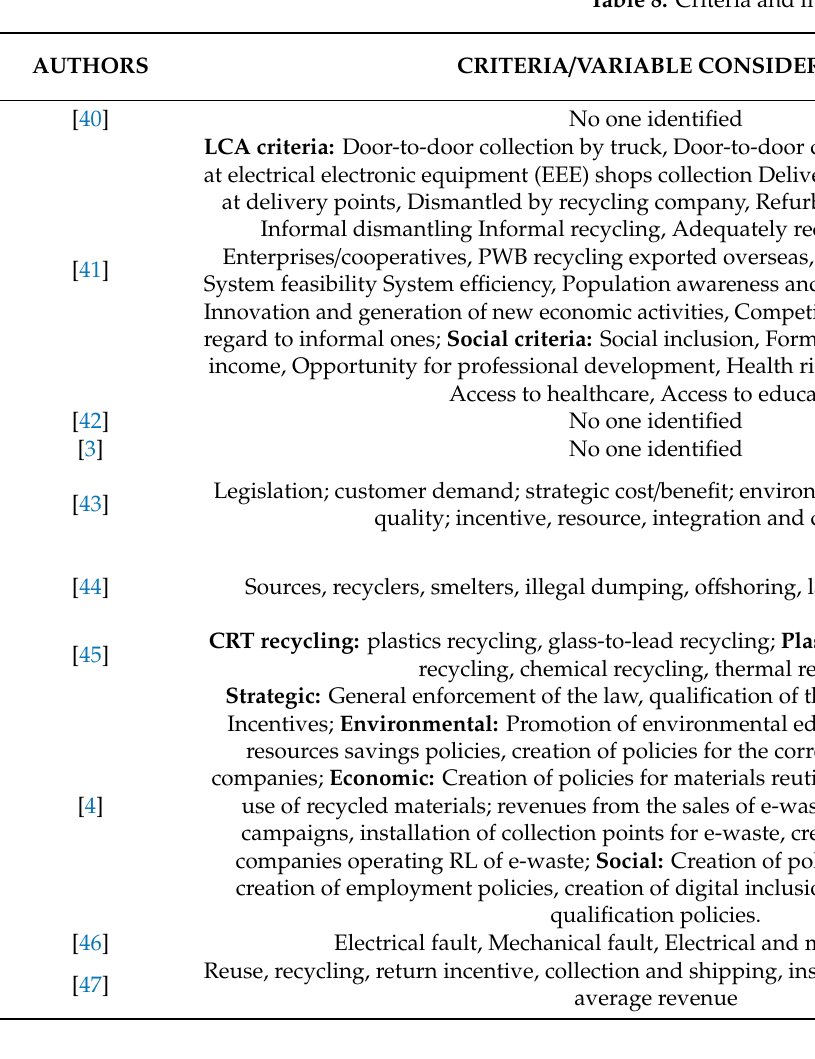
Table 8. Criteria and methods used in